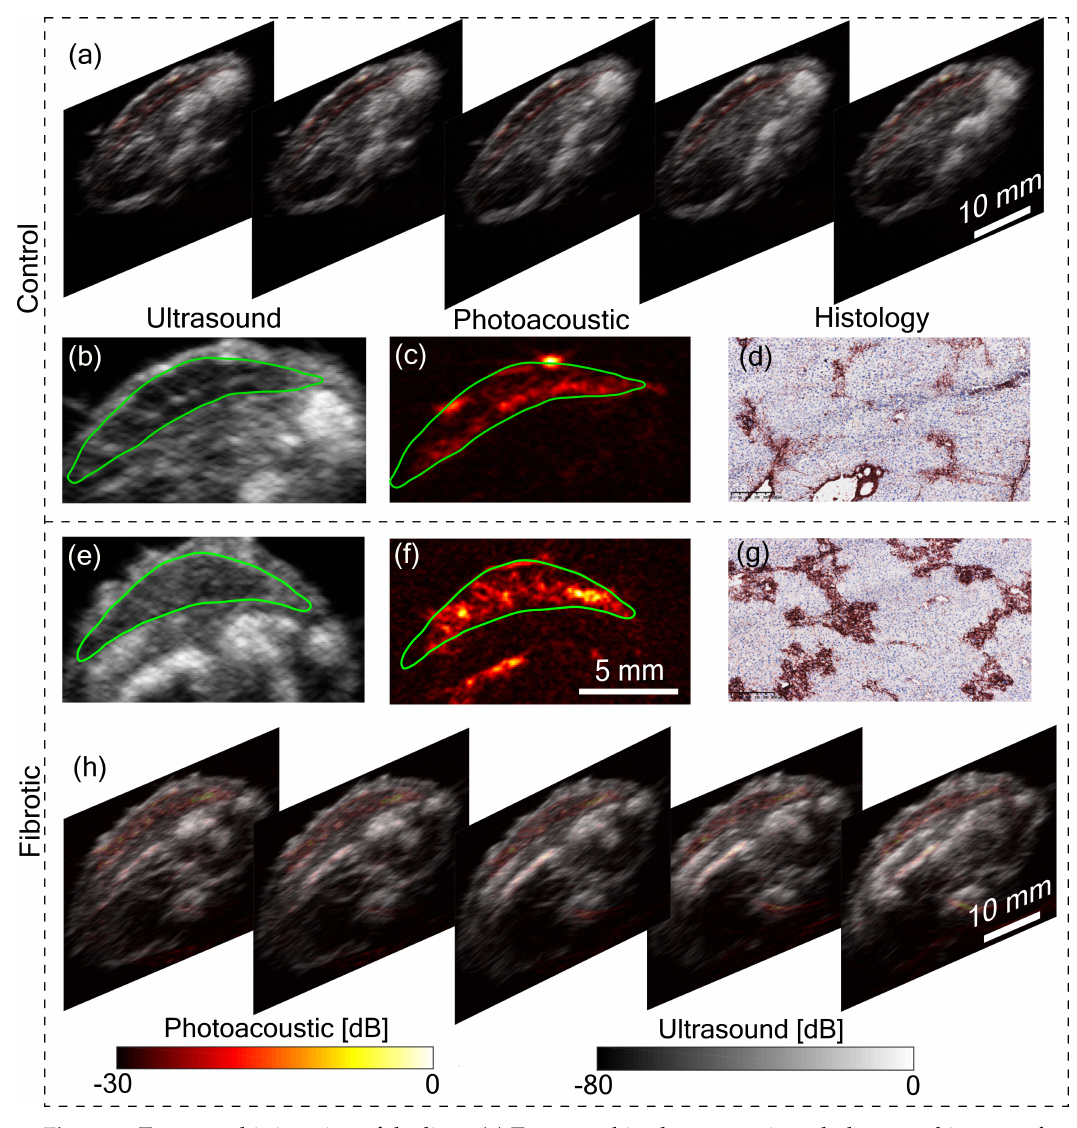
Figure 3. Tomographic imaging of the liver. ( a ) Tomographic photoacoustic and ultrasound images of a control mouse showing the liver at a scanning step of 2 mm. ( b ) Ultrasound image of the liver and ( c ) corresponding photoacoustic image. The green line markers the liver region. ( d ) Histology image of the control liver stained with Collagen I (fibrosis marker). ( e ) Ultrasound image of a mouse liver with fibrosis (CCl 4 -treated) and ( f ) corresponding photoacoustic image. ( g ) Histology image of the fibrotic liver stained with collagen I (fibrosis marker). ( h ) Tomographic photoacoustic and ultrasound images of the fibrotic mouse showing liver at a scanning step of 2